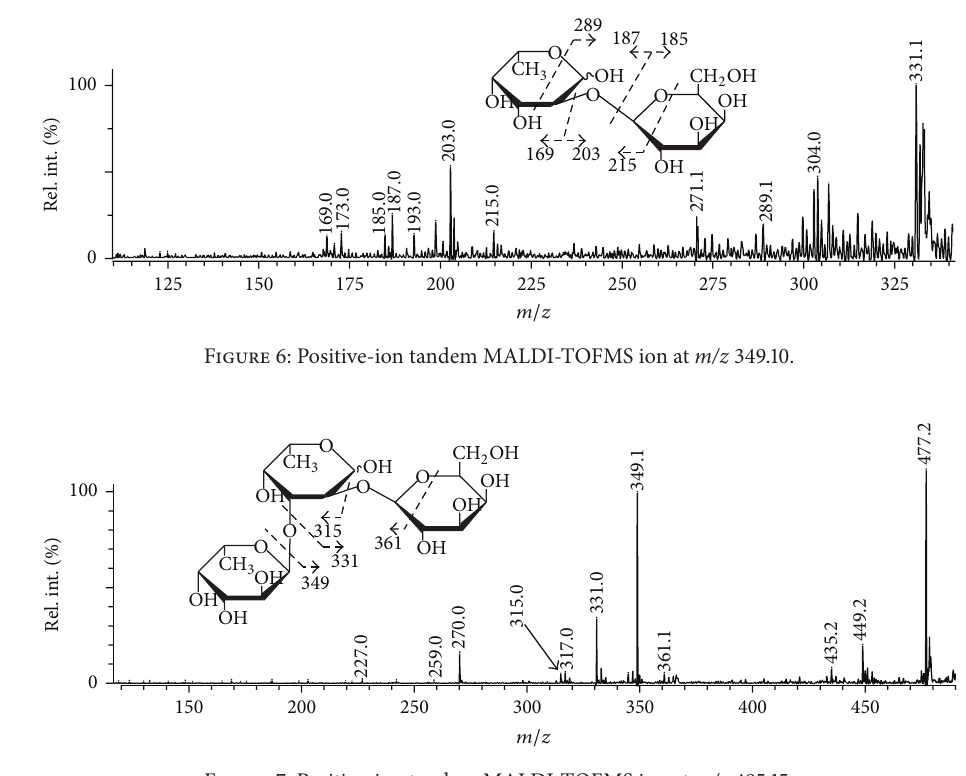
Figure 7: Positive-ion tandem MALDI-TOFMS ion at m/z